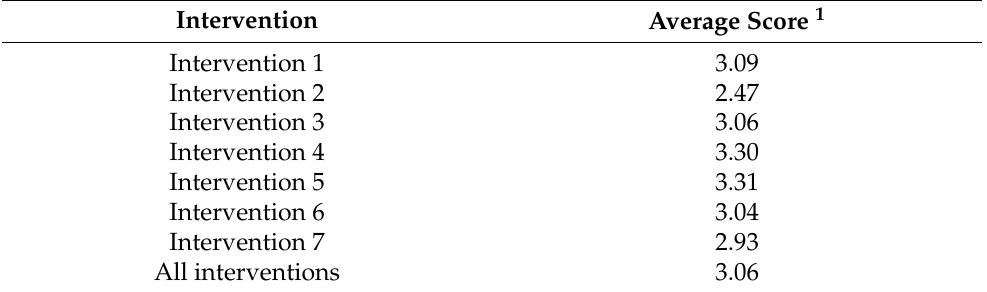
Table 4. The average score of the utility perceived by adolescents in the different